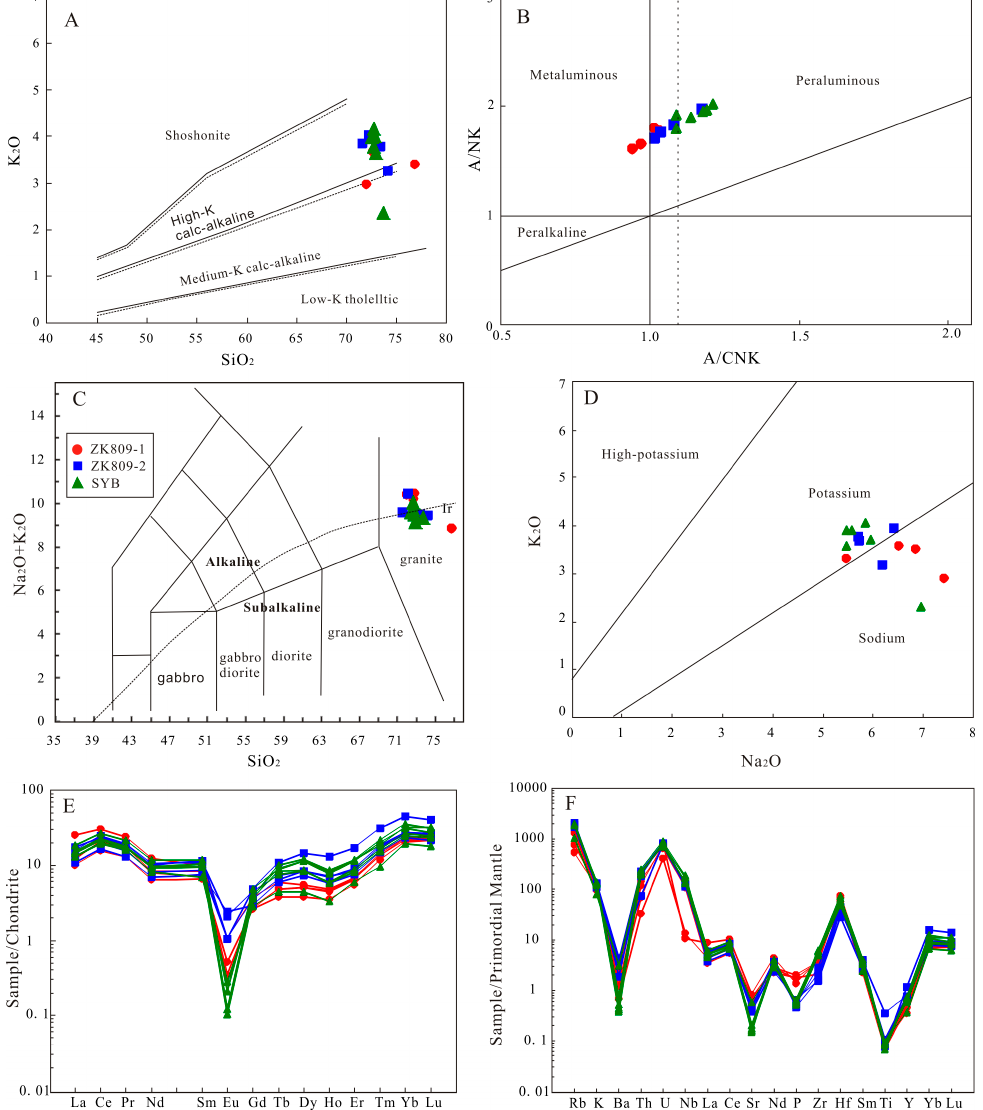
Figure 8. ( A ) SiO 2 versus (Na 2 O+ K 2 O) diagram (Middlemost, [55]) ; ( B ) Na 2 O versus K 2 O diagram (Middlemost, [56]) ; ( C ) SiO 2 versus K 2 O diagram (Peccerillo et al. [53]) ; ( D ) A/CNK versus A/NK diagram (Manlar and Piccoli, [54]) ; ( E ) Chondrite-normalized REE variation (normalized values are from [57] ); ( F ) Primitive mantle-normalized trace element patterns （ normalized values are from [58] .